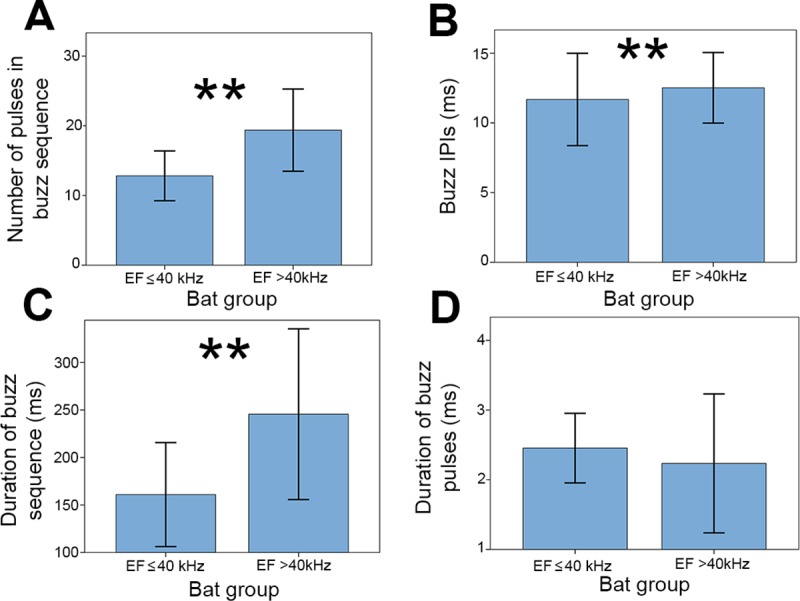
Differences in acoustic parameters of drinking buzzes between bat groups.Low frequency and high frequency bats are separated into two groups by EF (x axis on all graphs). (A) Number of pulses within a buzz sequence. (B) IPI (ms) for buzzes. (C) Duration (ms) of the entire buzz sequence for a bout. (D) Duration (ms) of individual pulses within a buzz. Data are plotted as means and one standard deviation. Terminal pulses (Fig 2) are not included in these analyses. Statistically significant values for independent t-test comparisons are indicated by double asterisks (**). Independent t-test comparisons are indicated by double asterisks (**).